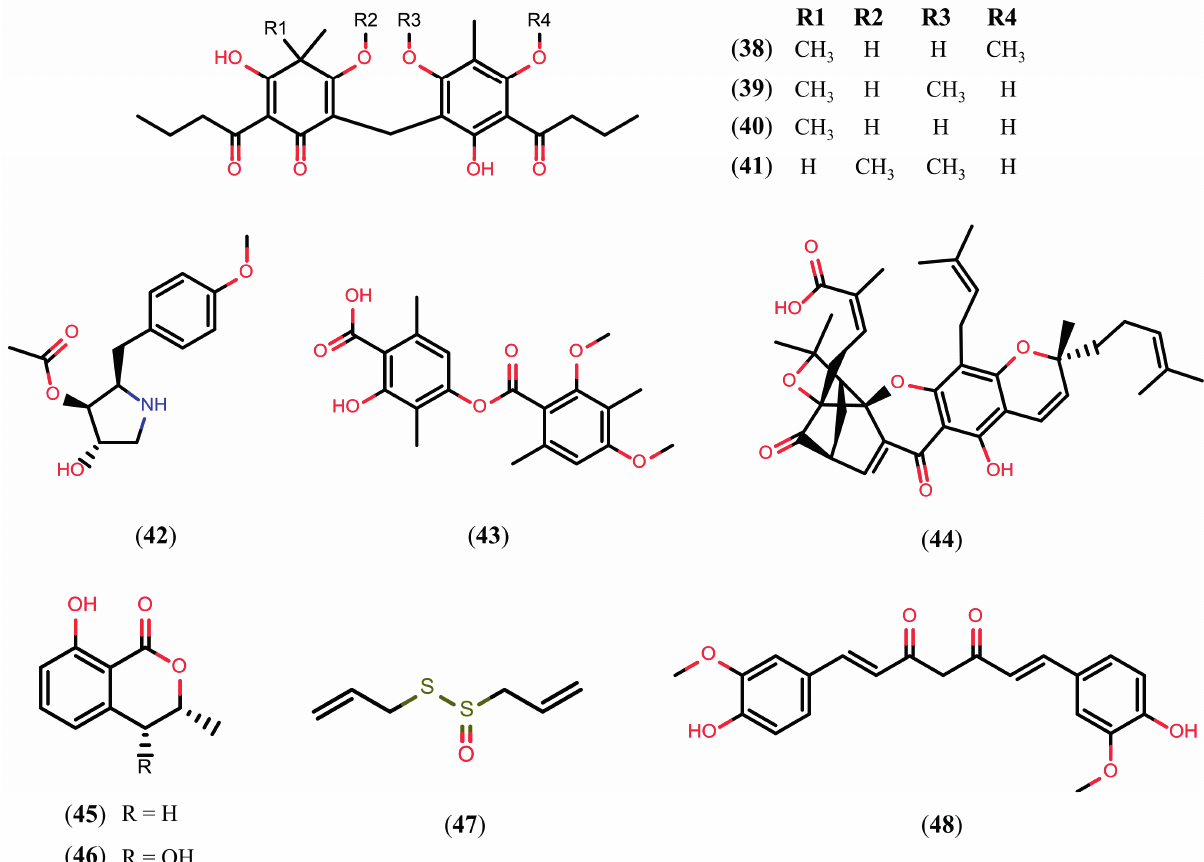
Figure 9. Chemical structures of other NPs known to have schistosomicidal